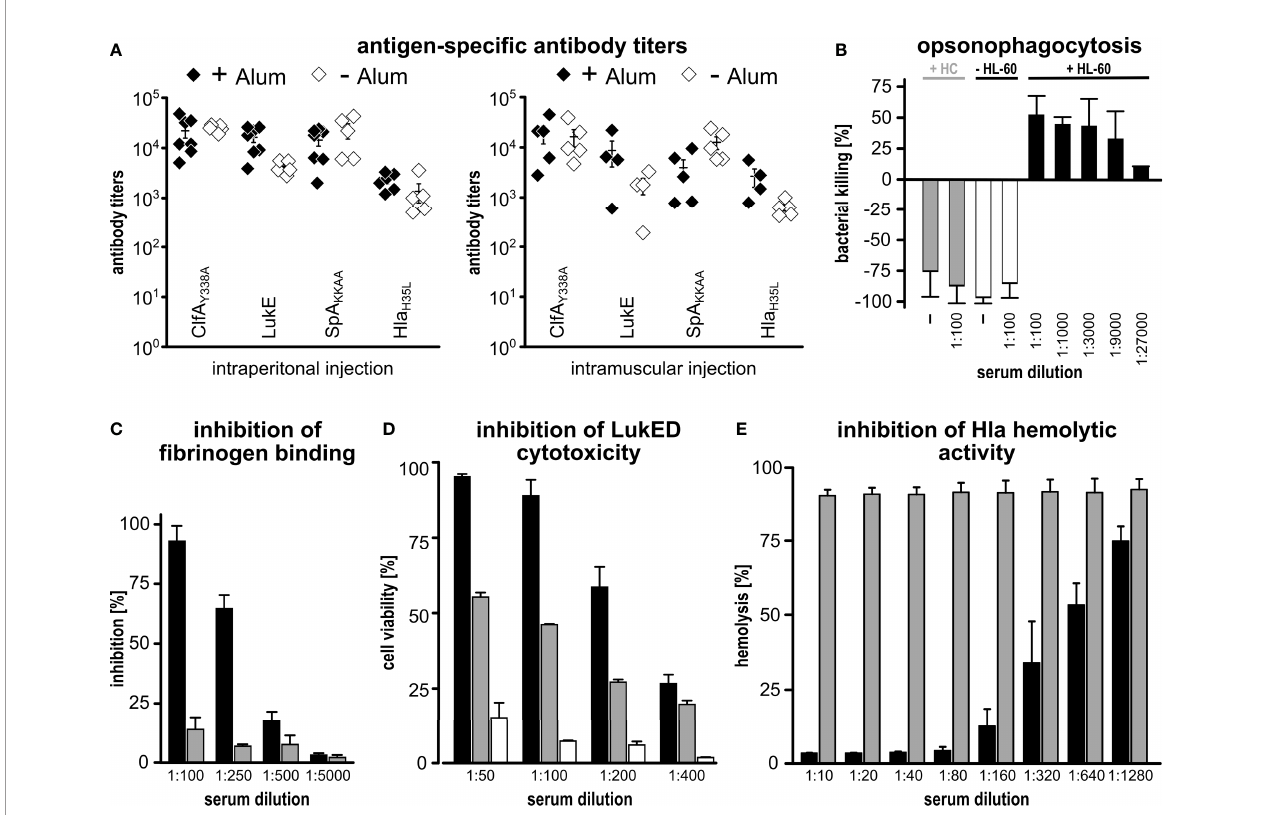
FIGURE 2 | Immunogenicity of CLSH-OMVs D 60 . (A) Antigen-speci fi c antibody titers. Groups of 8 female CD1 mice were immunized i.p. (left panel) or i.m. (right panel) 3 times at 2-week intervals with 20 m g of CLSH-OMVs D 60 formulated with or without Alum ( fi lled and open symbols, respectively). Sera were collected 7 days after the last immunization and IgG titers were analyzed by ELISA using plates coated with the respective puri fi ed recombinant protein (300 ng/well). Each data point represents the antibody titer from a single mouse. Mean ± s.e.m. is shown. (B) Opsonophagocytosis killing (OPK). 500 CFUs of S. aureus Newman strain grown in TSB at 37°C were incubated with serially diluted immune sera for 45 minutes at RT. Then, 3×10 5 HL-60 cells differentiated into neutrophils and guinea pig complement were added to each reaction for 90 minutes at 37°C (T90). Bacterial killing refers to the CFUs of the negative control (bacteria + HL-60 cells + complement without serum) set as 0% killing and was calculated as follows: [CFUs of the negative control at T90 - CFUs of each sample at T90]/CFUs of the negative control at T90] . Data are reported as mean ± s. d. of two independent experiments. HC: heat-inactivated complement. (C) Inhibition of fi brinogen binding . S. aureus Newman strain (1×10 7 CFUs/well) was pre-incubated for 30 minutes at RT with serially diluted pooled sera from mice immunized with either 20 m g of fi brinogen (10 µg/ “ empty ” OMVs D 60 (grey bars) or 20 m g of CLSH-OMVs D 60 (black bars). Mixtures were transferred to a 96-well plate previously coated with human ml) and incubated for 1 hour at 37°C. Adherent bacteria were fi xed with formaldehyde and then stained with crystal violet. Adherence to fi brinogen was calculated as a percentage of values measured in control wells lacking serum (= 100%), and inhibition of binding to fi brinogen was calculated by subtracting the adherence percentage values from the control (= 100% - x %). The graph shows the mean ± s. d. of three independent experiments. (D) Inhibition of leukocidin-mediated cytotoxicity . HL-60 cells differentiated into neutrophils (5×10 5 /well) were incubated for 24 hours at 37°C with LukED (200 nM) in presence of serially two-fold diluted sera from mice immunized with 20 m g of CLSH-OMVs D 60 (black bars), “ empty ” OMVs D 60 (grey bars) or with Alum (white bars). For assessment of cell viability, the XTT Assay reagent was added and after 16-hour incubation at 37°C the absorbance was read at 470 nm. Data are reported as mean ± s. d. of two independent experiments. (E) Inhibition of Hla-mediated hemolysis . Serially two-fold diluted sera from mice immunized with either 20 m g of “ empty ” OMVs D 60 (grey bars) or 20 m g of CLSH-OMVs D 60 (black bars) were pre-incubated with recombinant Hla for 20 minutes at RT and then with rabbit erythrocytes for 30 minutes at 37°C. Hla hemolytic activity was calculated as percentage of hemolytic activity obtained for rabbit erythrocytes incubated with water (100% hemolysis). The graph shows the mean ± s. d. of three independent